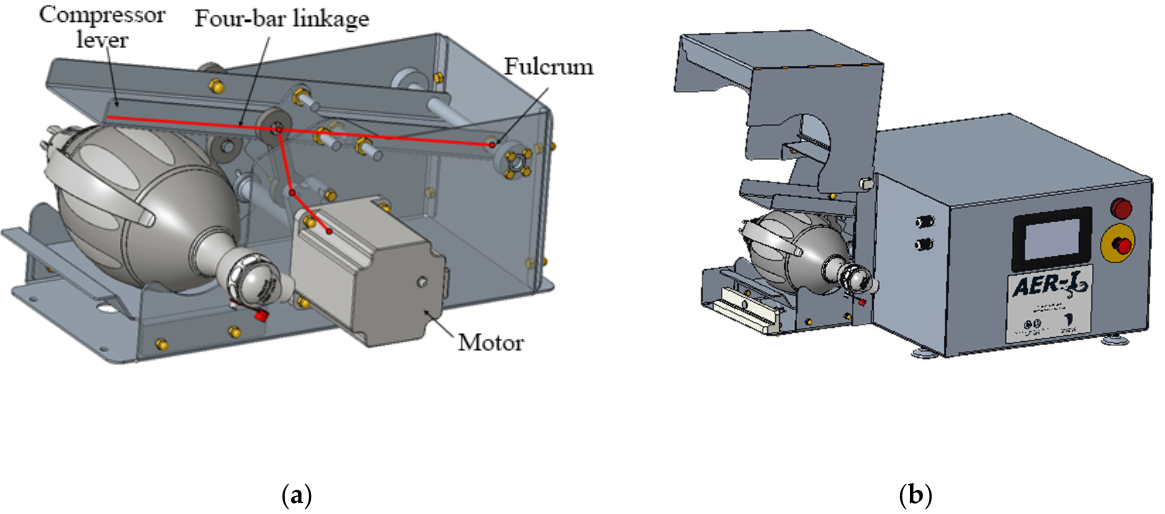
Figure 8. Detail design of the automation mechanism; ( a ) internal four-bar mechanism; ( b ) housing (opened).